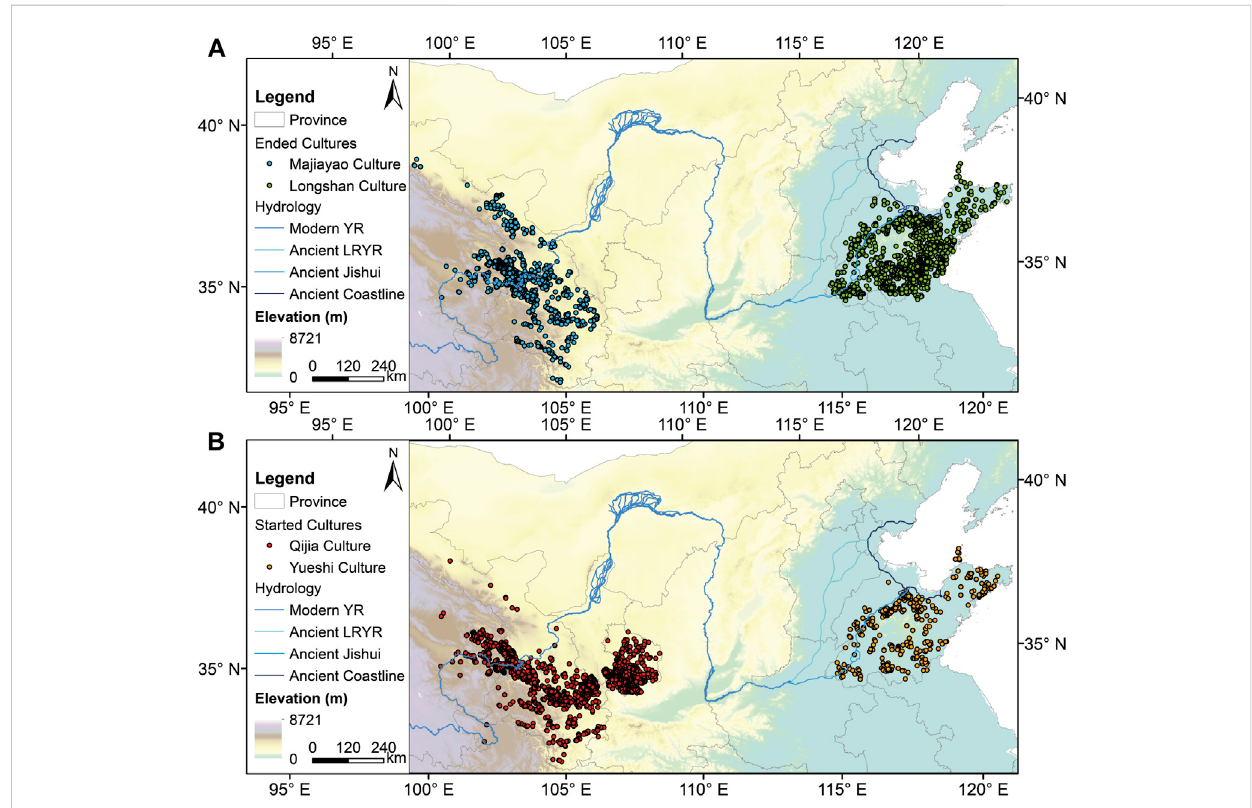
FIGURE 2 Distributions of archaeological sites between different cultures during 4200 – 3900 BP. Note: (A) ended cultures, including the Majiayao culture (blue) and the Longshan culture (green); (B) started cultures, including the Qijia culture (red) and the Yueshi culture (orange). The courses of the modern Yellow River (YR), the ancient lower reaches of the Yellow River (LRYR) plus the ancient Jishui River, and the ancient coastline of the North China Plain were depicted from Tan (1982) as